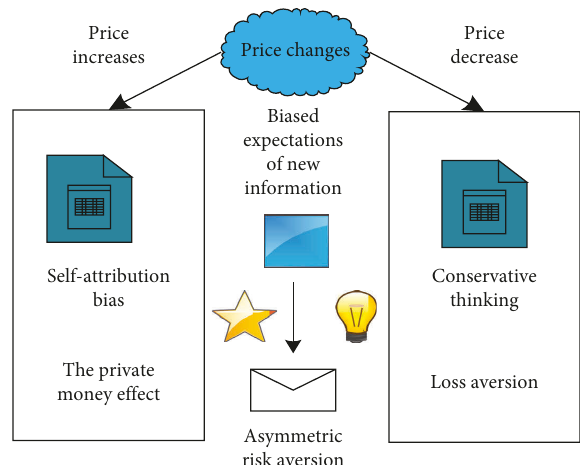
Figure 2: A descriptive model of behavioral finance.